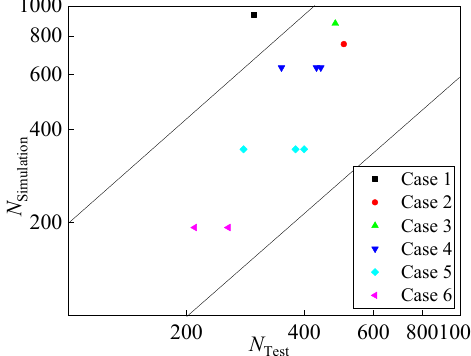
Figure 8. Thermal fatigue test and simulated data [14,37].